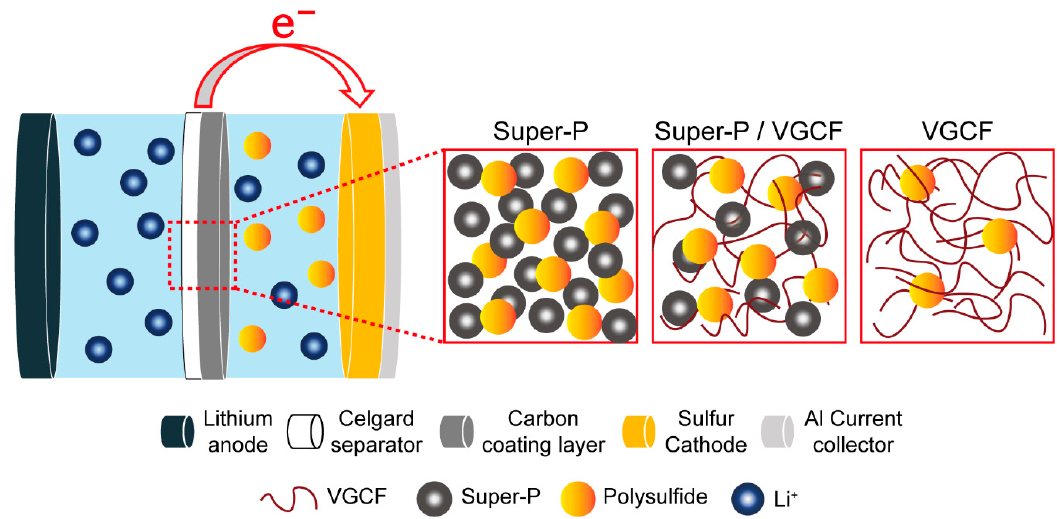
Figure 7. Schematic representation of polysulfide immobilization by Super-P-rich separators in Li–S cells. The black and yellow spheres represent lithium and sulfur particles, respectively.